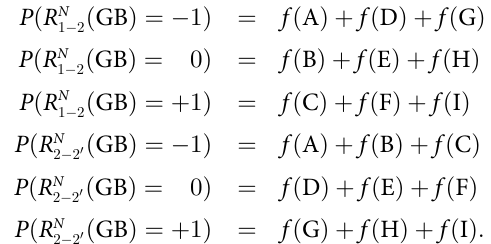
Fig 5. The results of exhaustive conformational sampling and identification of structures satisfying the conditions. (A) Frequency of structures that satisfy the three conditions among exhaustively generated structures for the system I to IX. (B) Distributions of the computed register shifts of R N of the vertical axis of (B) and (C) were obtained by marginalizing the results of (A).